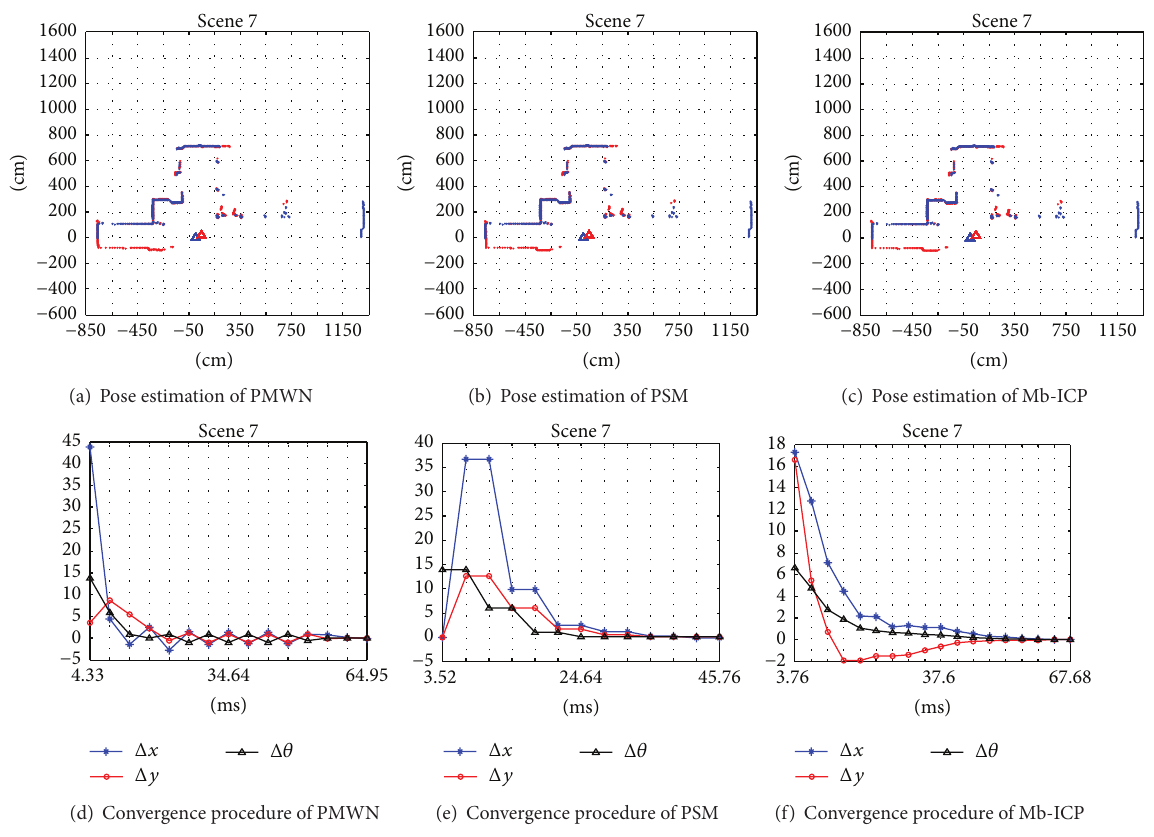
Figure 13: Scenes in Environment